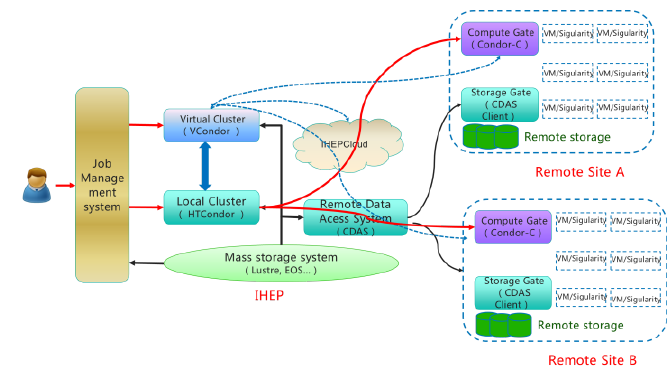
Figure 5. The workflow of Job Scheduler